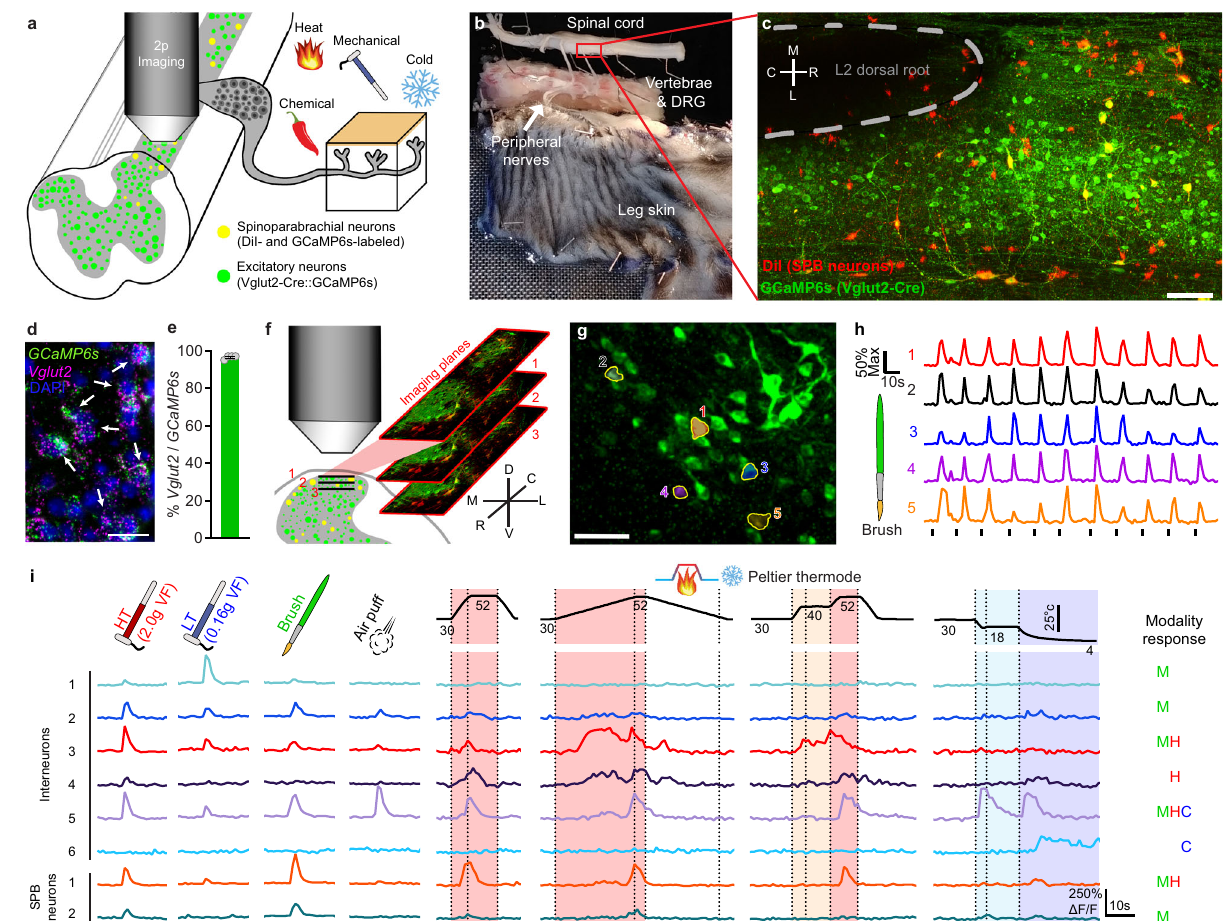
Fig. 1 | Population imaging in the ex vivo somatosensory preparation. a Schematic of the ex vivo somatosensory preparation and neuronal labeling strategy. b Picture of the ex vivo somatosensory preparation with a typical recording region rostral of the L1-L2 dorsal root entry zone highlighted in red. c Low-magni fi cation fl uorescenceimageoftheL2dorsalrootentryzone(scalebar, 100 µ m) showing GCaMP6s expression in Vglut2-Cre positive excitatory neurons (green) and SPB neurons (red). N =11 animals. Rostral (R), caudal (C), medial (M), and lateral (L) are indicated on the white cross. d Representative fl uorescence in situ hybridization of Gcamp6s (green) and Vglut2 (magenta) with DAPI (blue) in the super fi cial dorsal horn (scale bar, 25 µ m). e Percent of GCaMP6s SDH neurons whichexpress Vglut2 ( n =4mice,60 – 76 GCaMP6s +nucleiquanti fi ed/mouse).Data arepresentedasmeanvalues±SEM. f Schematicofthemulti-plane(XYZT)imaging protocolusedforCa 2+ imaging.3separateopticalplaneswithaspacingof14 µ mare